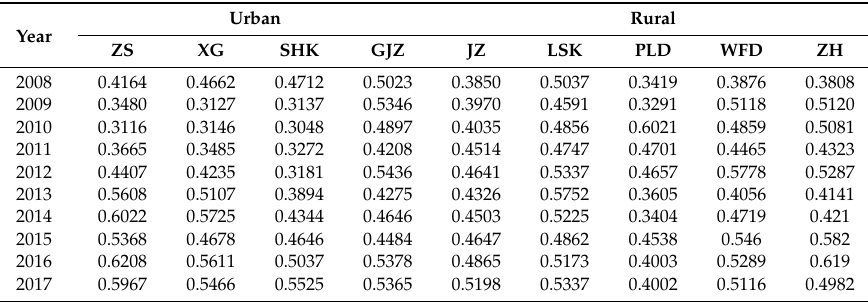
Table 3. Technique for order preference by similarity to ideal solution (TOPSIS) scores in urban and rural areas,